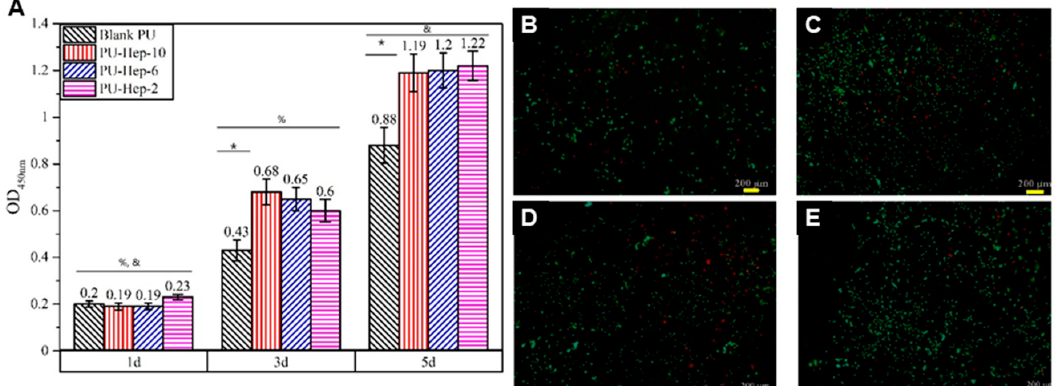
Figure 6. Cell proliferation ( A ) and live/dead cell staining on blank PU film ( B ) and heparinized PU films: PU-Hep-10 ( C ), PU-Hep-6 ( D ) and PU-Hep-2 ( E ). Within a group, sample marked with (*) are